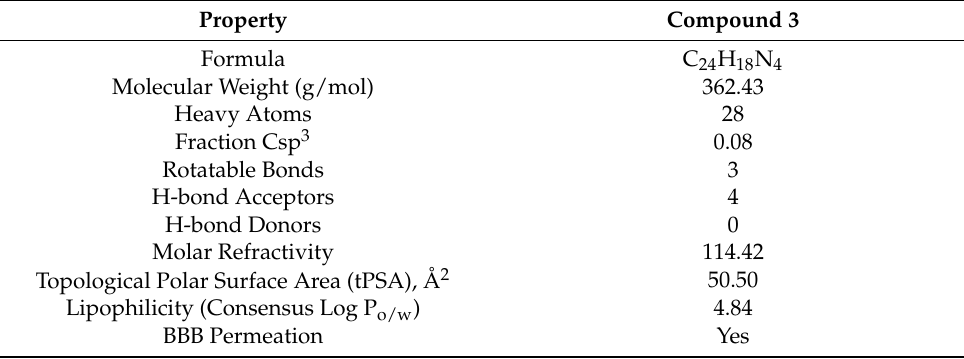
Table 1. Physicochemical ADME properties of compound 3